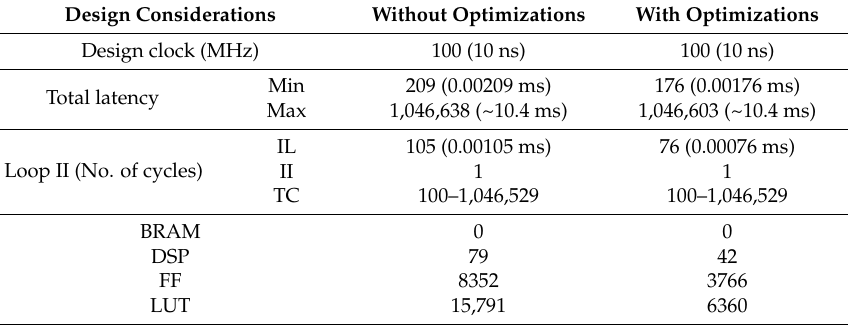
Table 4. Resource and latency optimizations of